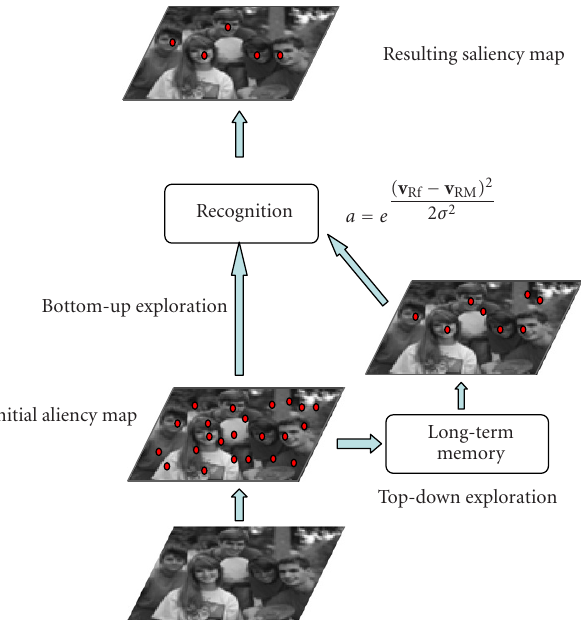
Figure 1: An overall presentation of the attentional model. A bottom-up saliency map is biased with the information on the de- sired target lying in long-term